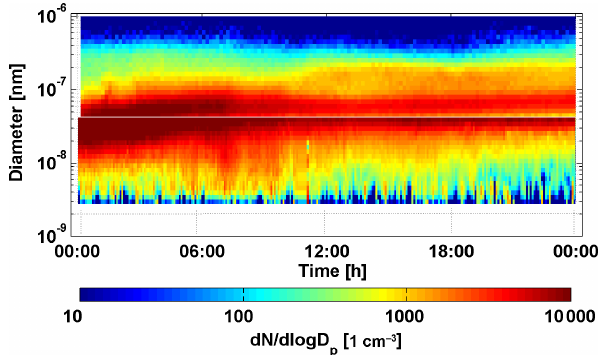
Figure 19. Merging particle size distributions measured with the NAIS in the size range 2.5–40nm and with the DMPS in the size range 40–1000nm on 23 April 2007 in Hyytiälä, Finland.